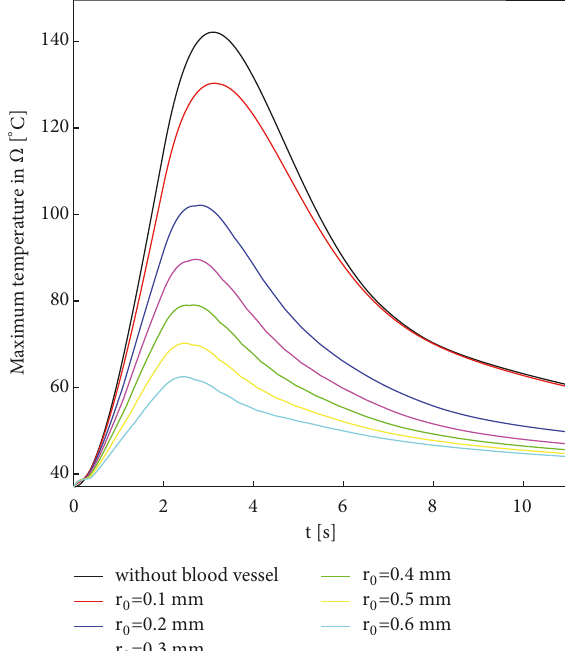
Figure 8: Maximum temperature in space 𝑟, 𝑧 ∈ Ω versus time with different radius of blood vessel for 𝑝 0 = 2 × 10 5 𝑝𝑎 , 𝑢 𝑎 V 𝑒 = 5𝑐𝑚/𝑠 , 𝑑 = 0 𝑚𝑚 , 𝜏 = 1.756 𝑠 , 𝑓 = 1 𝐻𝑧 , 𝑓𝑎𝑐 = 0.5 , 𝑡 = 2𝑠 𝑝 ℎ